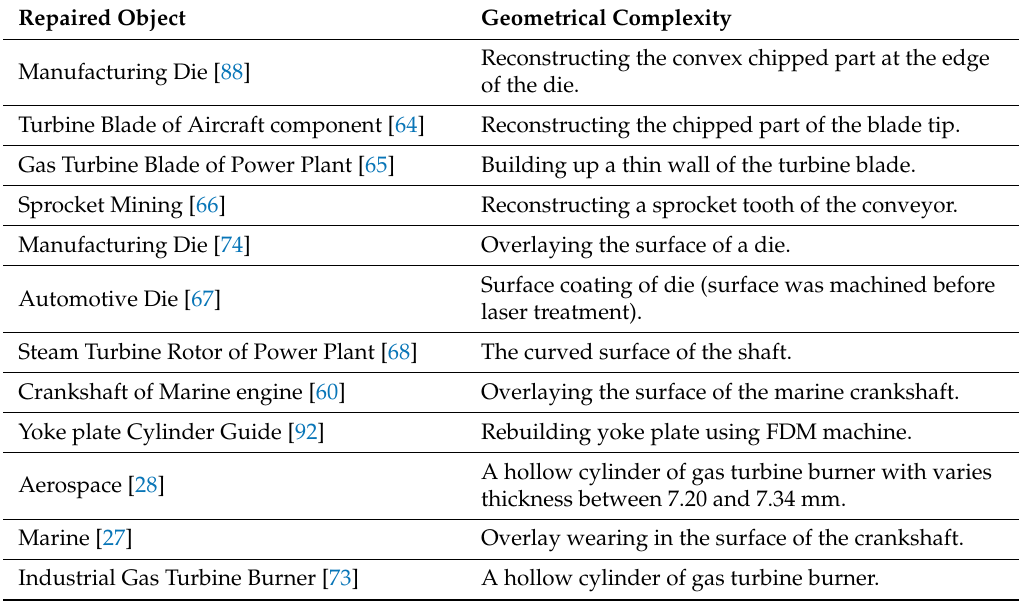
Table 8. Reparation of objects with geometrical